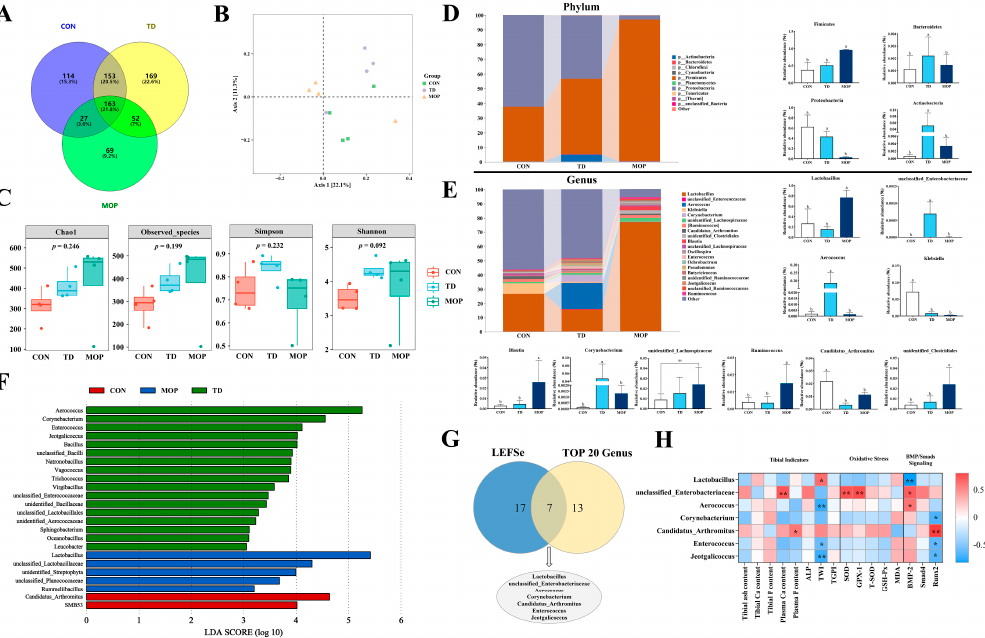
Figure 6. Effects of MOP on the gut microbiota of broilers. ( A ) The Venn diagram analysis of OTUs. ( B ) PCoA is based on the unweighted − UniFrac distance matrix of OTUs. ( C ) Chao1 diversity; observed_species; Simpson; Shannon diversity. ( D ) Relative abundance of gut microbiota composition at the level of phylum. ( E ) Relative abundance of gut microbiota composition at the level of genus. ( F ) LDA scores show the significant bacterial differences in the (log LDA >3.0; n = 4 chickens/group). ( G ). The Venn diagram for LEfSe and the abundance of the top 20 bacterial taxa at the genus level. ( H ) Correlation analysis of tibia-related parameters, bone metabolism-related parameters, oxidative stress and BMP/Smads signaling pathway with gut microbiota. Bars with no common small letters (a, b, c) indicate statistical differences among the three groups ( p < 0.05). ns showed no statistical significance among the three treatment groups ( p >